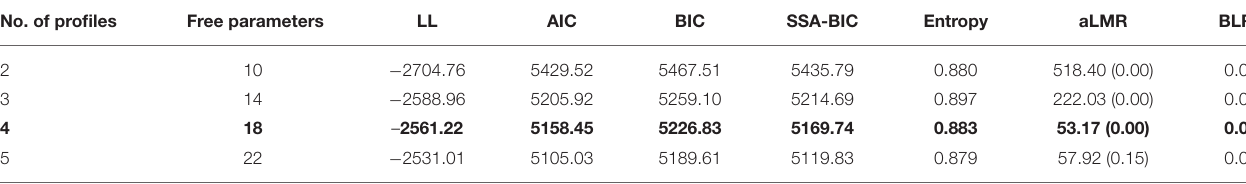
TABLE 3 | Model fit information for latent profile analysis.